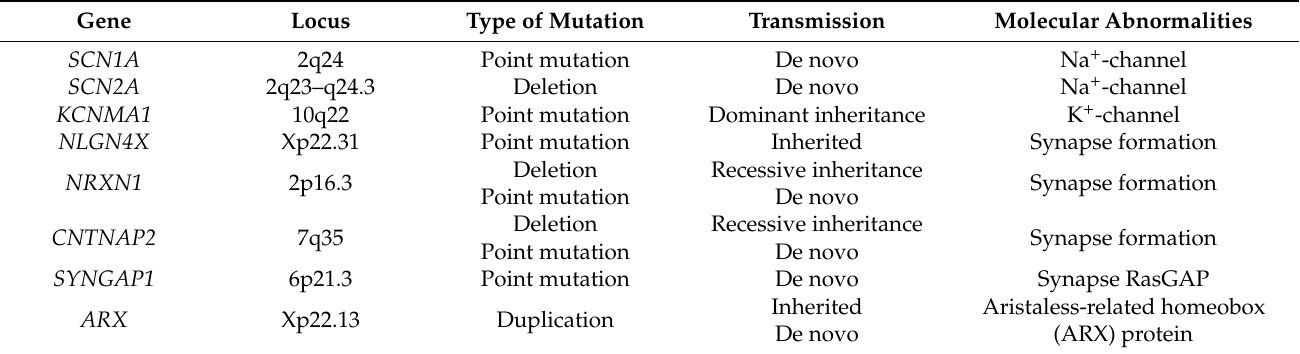
Table 1. Examples of genes linked with both ASD and epilepsy. (Modified from Amiet et al., 2013, and Betancur,